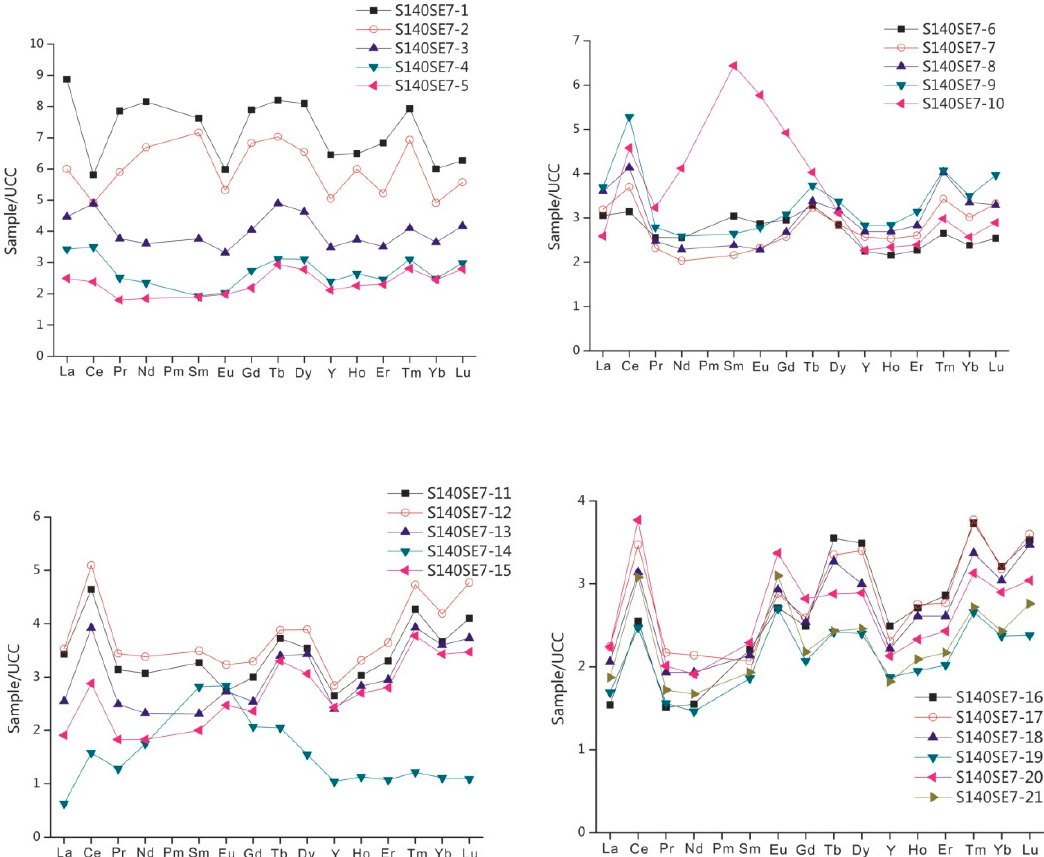
Figure 7. Distribution patterns of REE in the tuff samples from Zhongliangshan mine. REE are normalized by Upper Continental Crust [26].